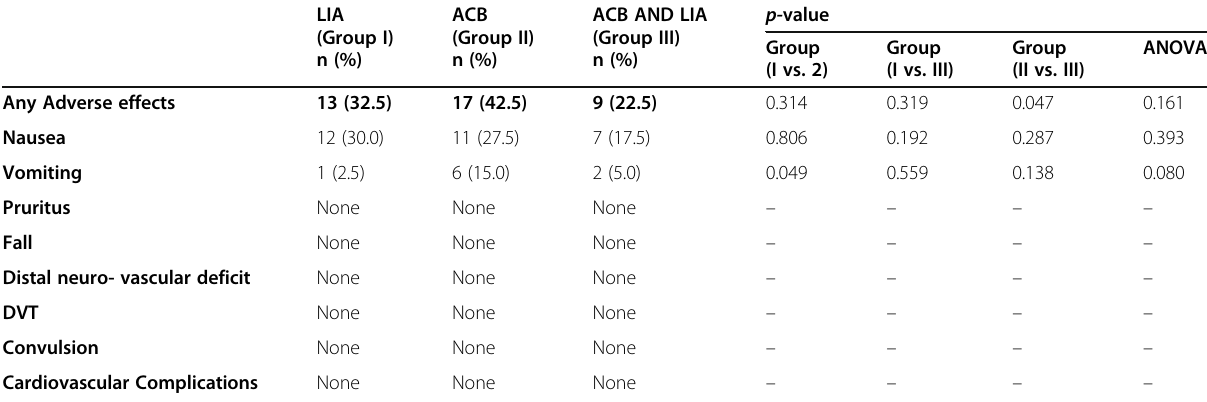
Table 3 Adverse